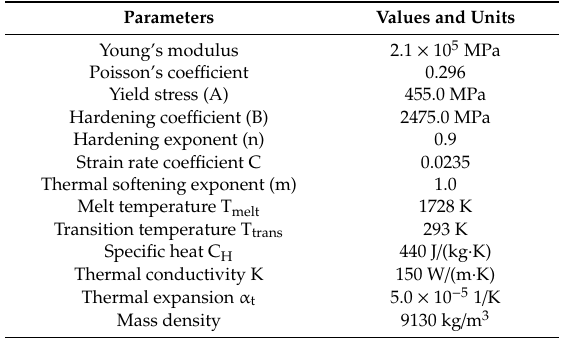
Table 1. Parameters of the Johnson-Cook material model for